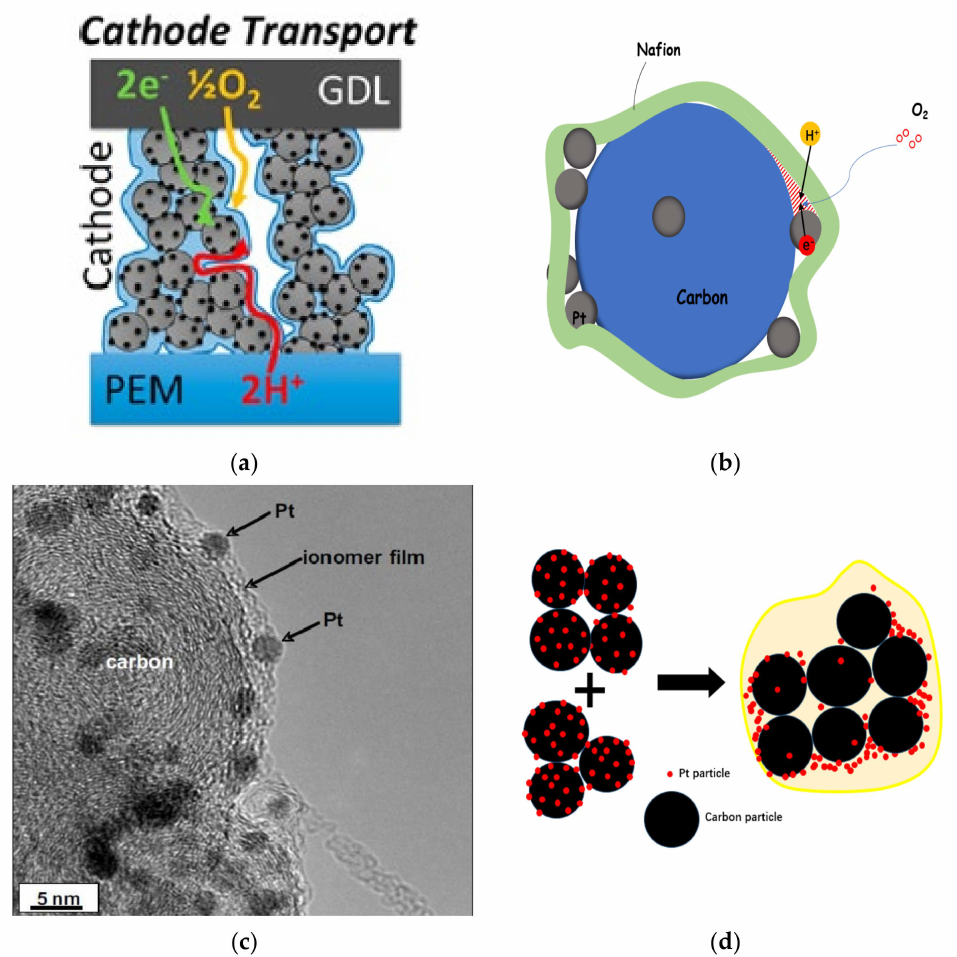
Figure 4. ( a ) Schematic diagram of MEA cathode side structure and electron and proton [67]. Copyright 2015 American Chemical Society. ( b ) Schematic diagram of three-phase boundary of PEMFC cathode. ( c ) Microstructure of Pt particle/ionomer/carbon support as shown by scanning electron microscope (SEM) [68]. Copyright 2006 ECS transactions. ( d ) Secondary distribution of Pt nanoparticles on support during the CL